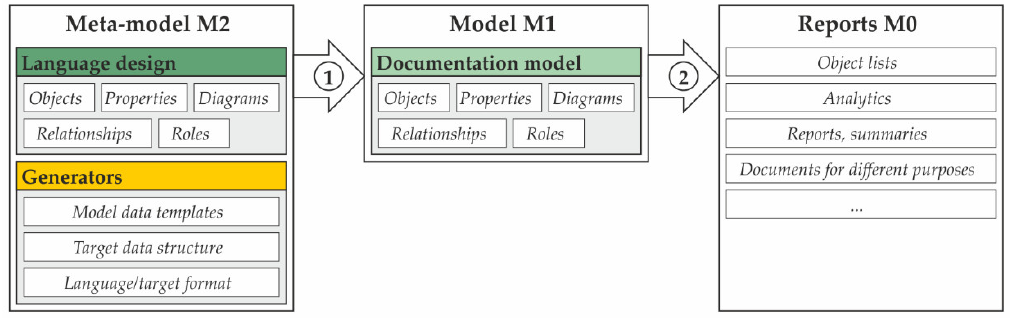
Figure 19. Reporting workflow.